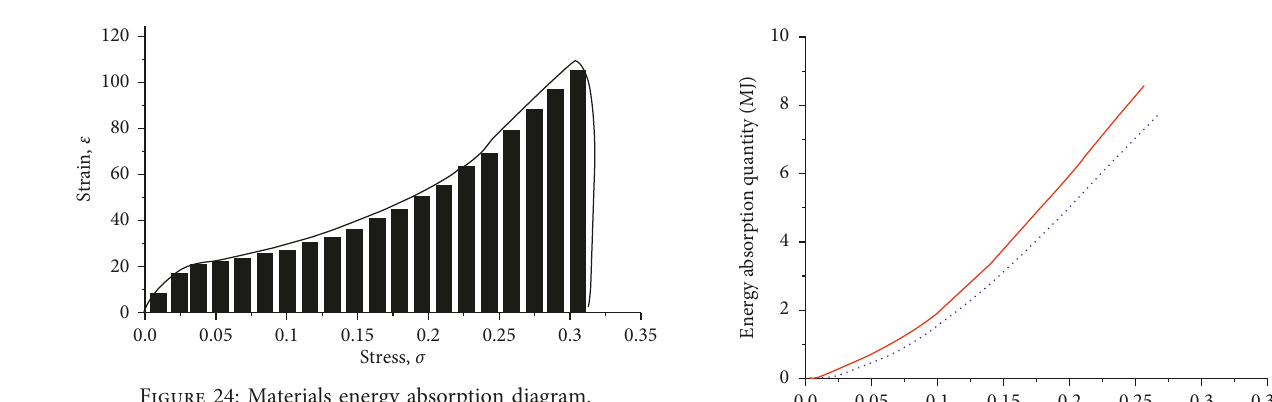
Figure 24: Materials energy absorption diagram.